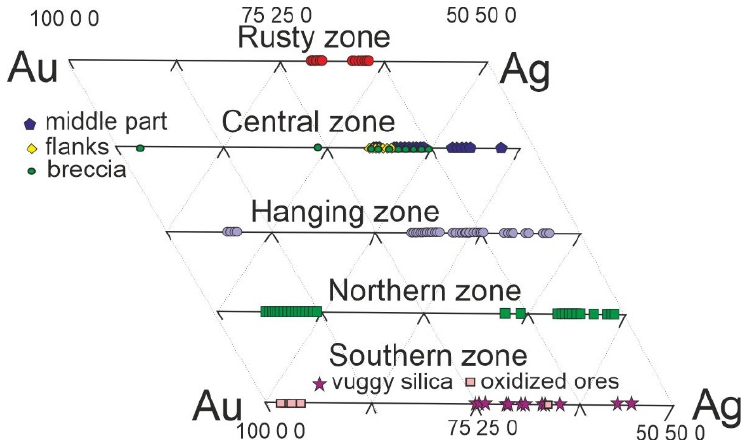
Figure 6. Variations in the composition of Au-Ag solid solutions from different ore zones of the Baranyevskoe deposit (data from Table 2). Table 2. Composition of Au-Ag solid solutions from different zones of the Baranyevskoe deposit, wt.